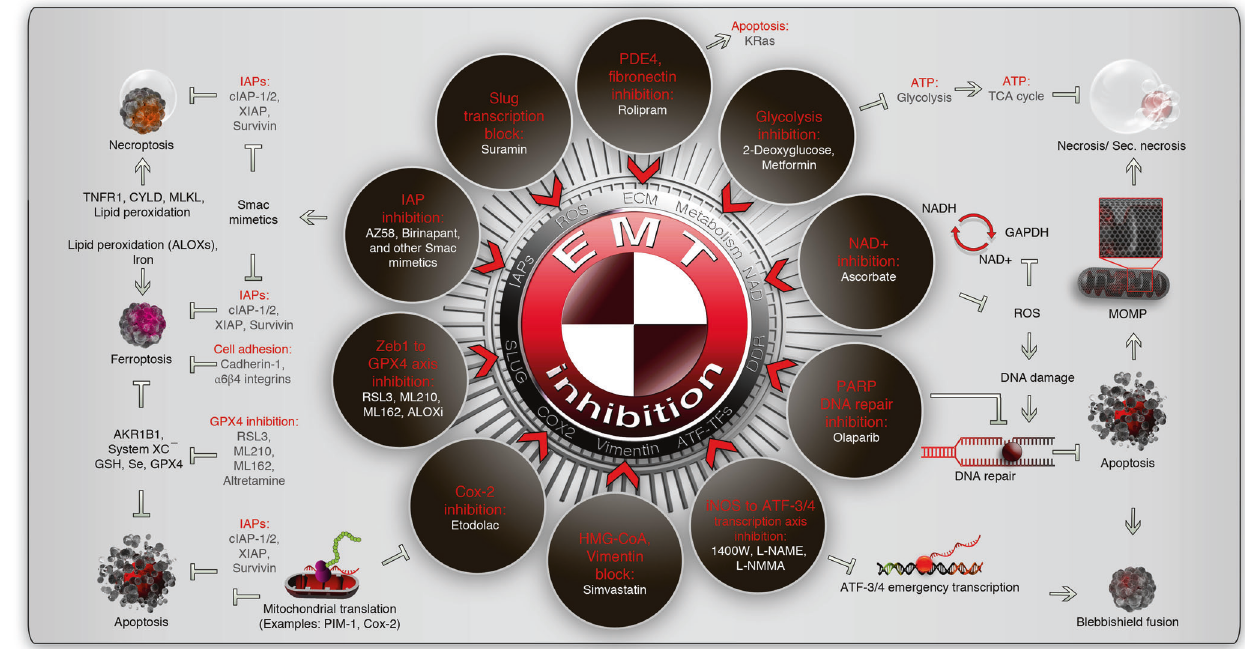
Fig. 7 Therapeutic vulnerable points which are common to EMT and BMW pathways of metastasis. The common repurposed drugs (white fonts) that aim to inhibit EMT in the contexts of various biological processes (red font) are indicated within brown rings. The EMT inhibitory drug connection to various cell death pathways are indicated outside the brown rings. Note that the IAPs are involved in the reversibility of various cell death forms. Some pathways, such as NAD + inhibition and PARP1 inhibition, are highly connected through DNA-damage response (DDR). See text for more details and caution statements. IAPs inhibitor of apoptotic proteins, TCA cycle tricarboxylic cycle, PDE4 phosphodiesterase-4, GPX4 glutathione peroxidase-4, iNOS inducible nitric oxide synthase, NAD nicotinamide adenine dinucleotide,